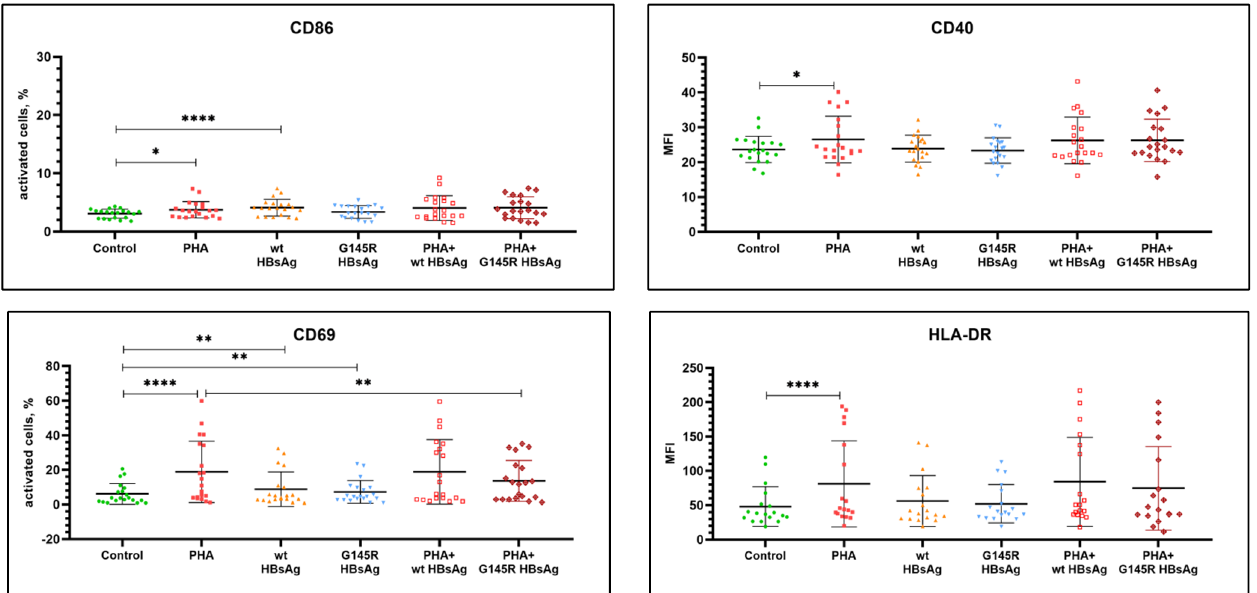
Figure 1. Assessment of surface markers on B cells stimulated with wild-type rHBsAg, the rHBsAg G145R mutant, or PHA, or their combinations. MFI—mean fluorescent intensity. Significant p values are reported as asterisks, where * p ≤ 0.05, ** p ≤ 0.01, and **** p ≤ 0.0001.